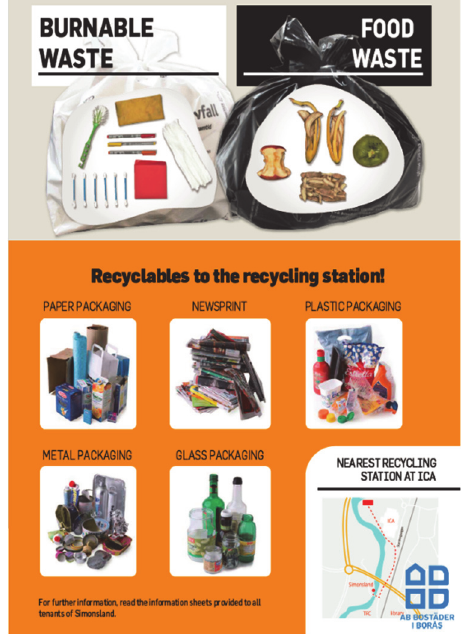
Figure A28. Poster displayed at all entrances and elevators.